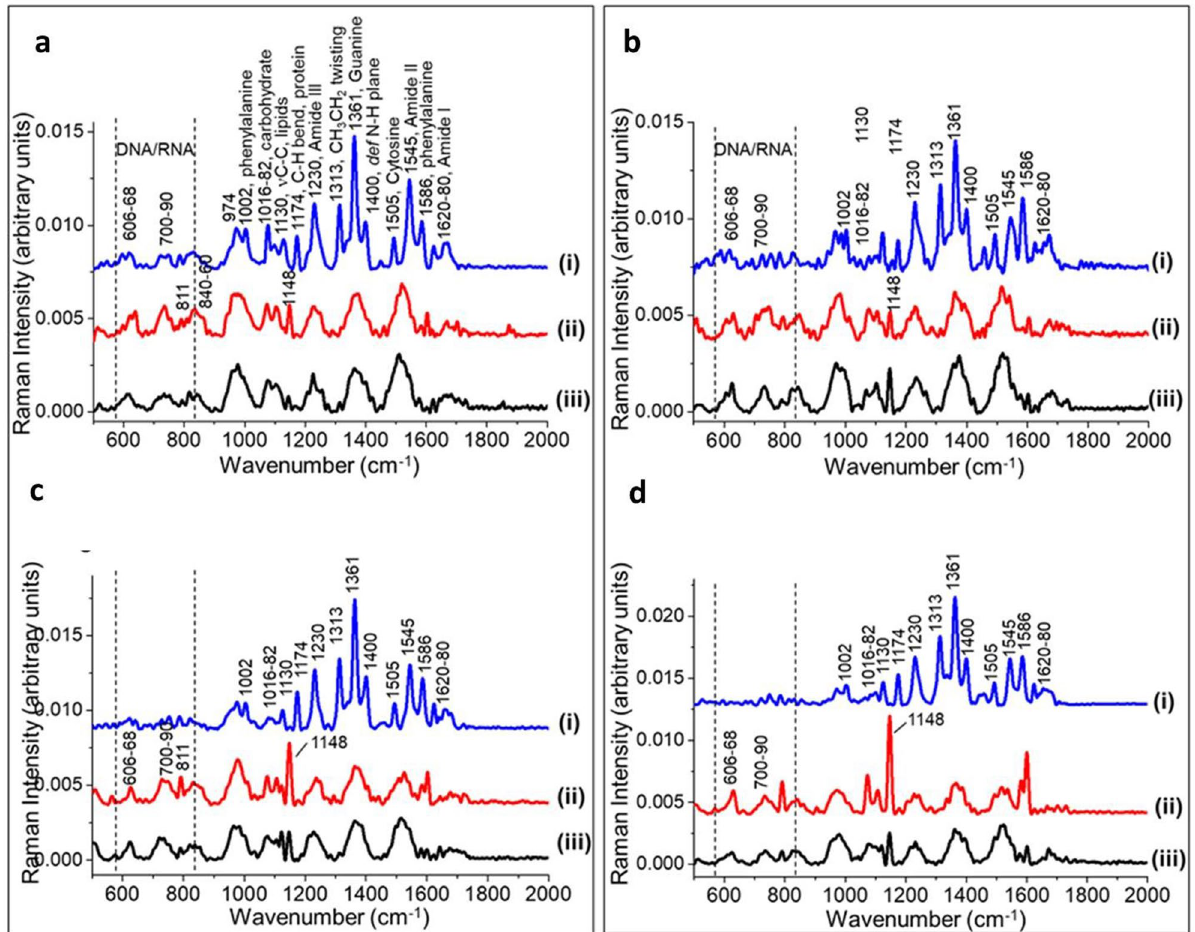
Figure 7. Averaged, intensity-normalised, background subtracted Raman spectra from planktonic cells (i) and biofilms grown at 10 °C (ii) and 25 °C (iii) of four bacterial strains [ P. fragi 1793 ( a ), P. lundensis 1822 ( b ), P. fragi 1832 ( c ), P. lundensis 49968 ( d )]. The dominant peaks for DNA/RNA, proteins and carbohydrate are shown with the peak assignments listed in Table